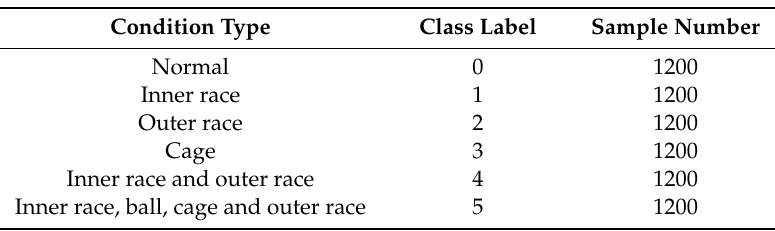
Table 1. Description of used bearing dataset. Table 2. Layer parameter configurations.